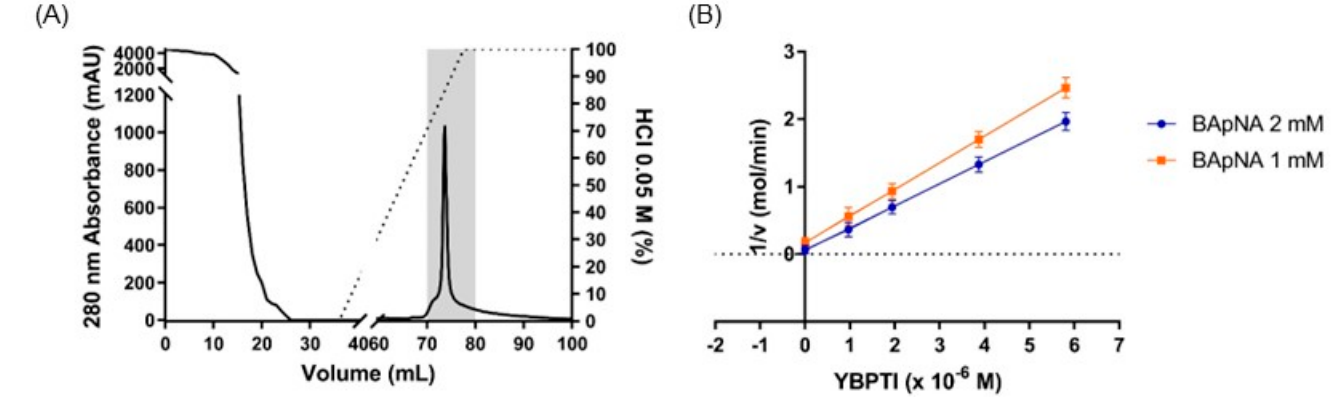
Figure 1. Purification and kinetic characterization of Yellow Bell Pepper trypsin inhibitor (YBPTI).